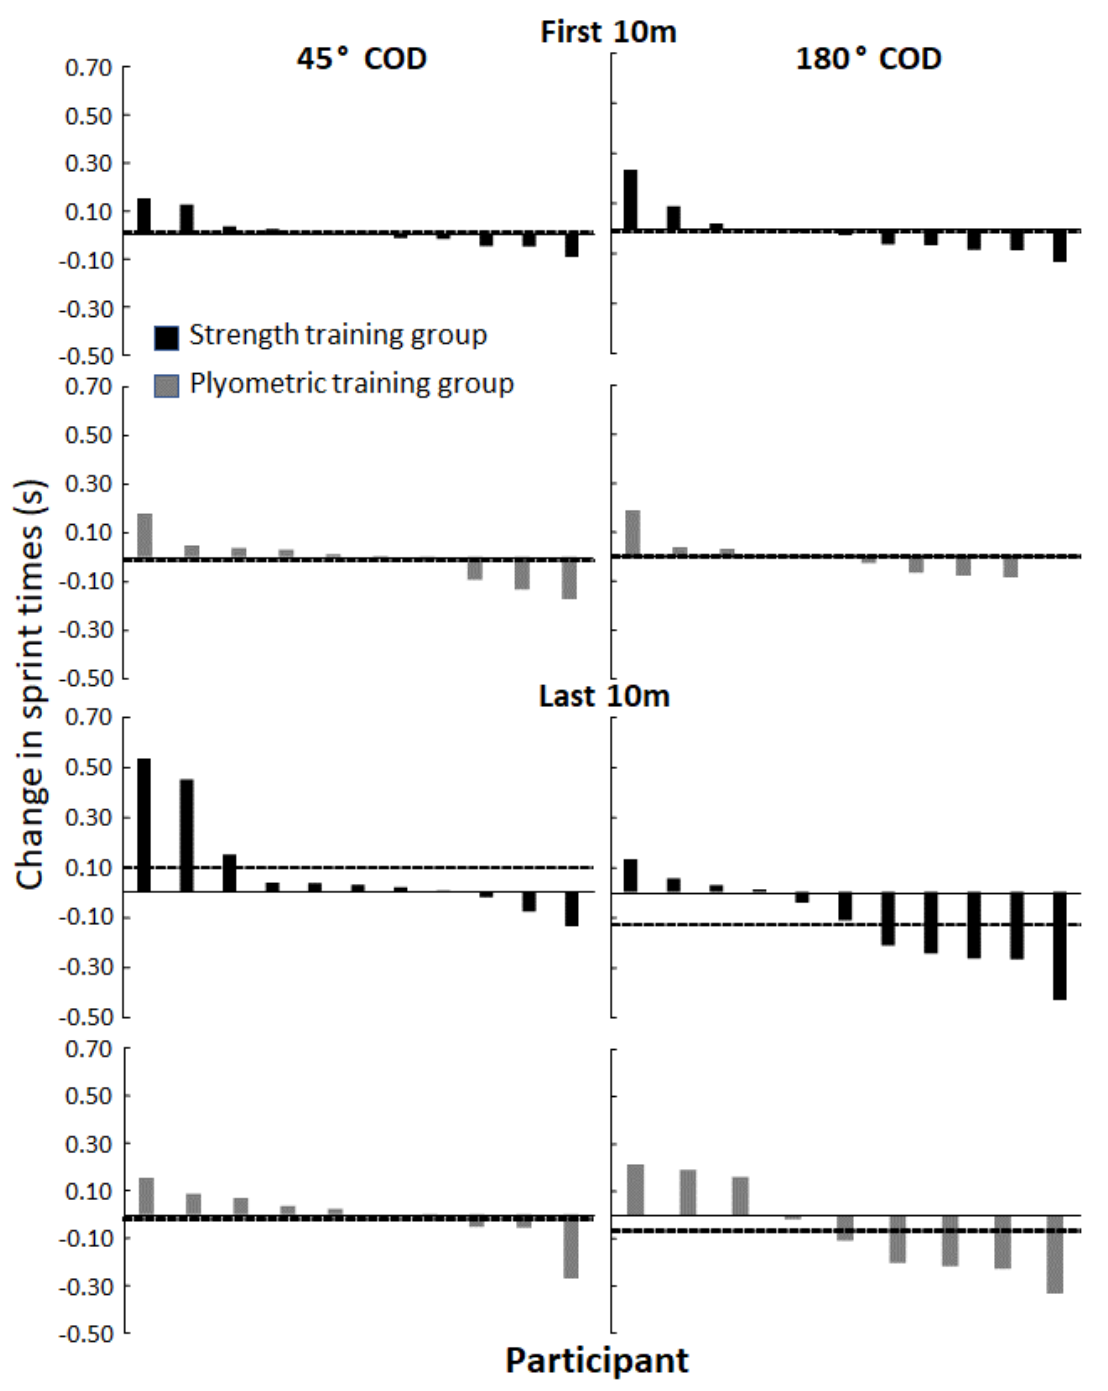
Figure 5. Individual responses displayed in seconds for both the strength and plyometric training groups in the 45° and 180° COD test at first and last 10 m. Average change in performance within the group is marked by a dotted line.